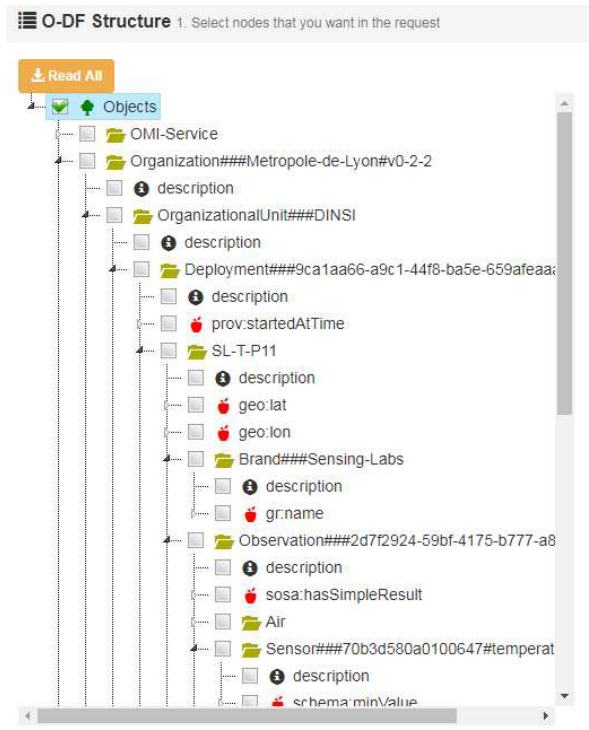
Figure 9. O-DF data